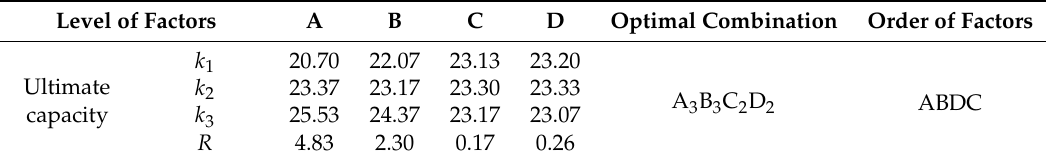
Table 6. Factor optimization analysis.